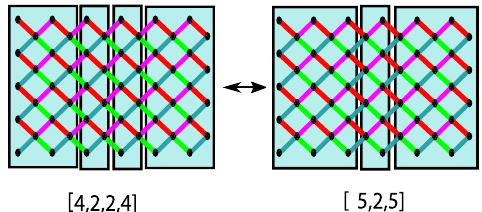
FIG. 14. Schematic of the split-and-merge algorithm for the ½ 4 ; 2 ; 2 ; 4 (cid:3) ↔ ½ 5 ; 2 ; 5 (cid:3) . The 2-qubit gates shown in red and dark green are performed in the ½ 4 ; 2 ; 2 ; 4 (cid:3) configuration and one switches to the ½ 5 ; 2 ; 5 (cid:3) to perform the light green and purple gates.